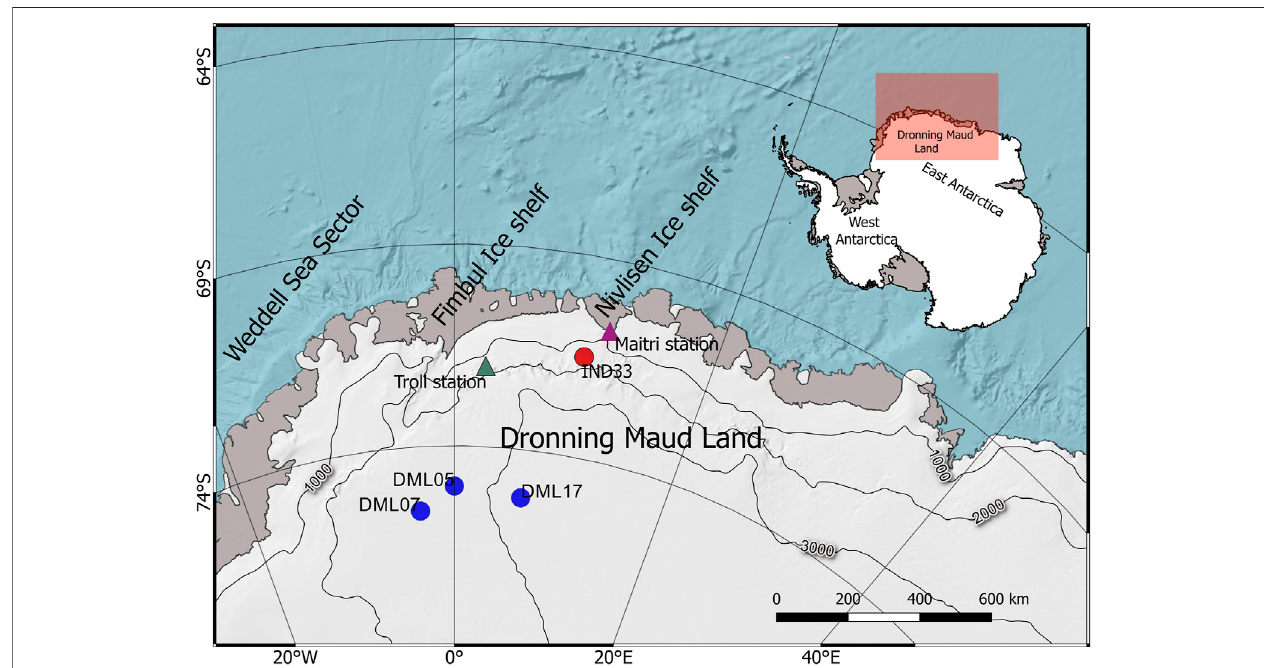
FIGURE 1 | Location map of Dronning Maud Land (DML), East Antarctica, showing the ice core sites. The fi lled red circle represents the location of the IND33 ice core, whereas blue circles denote the published ice core records of DML07, DML05, and DML17 (Graf et al., 2002) used in this study. Contour lines represent the elevation (in meters) of the study